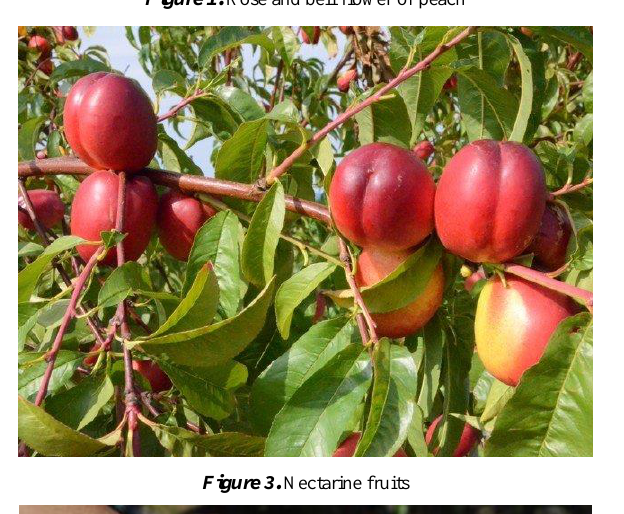
Figure 3. Nectarine fruits Figure 4. Snow white peach